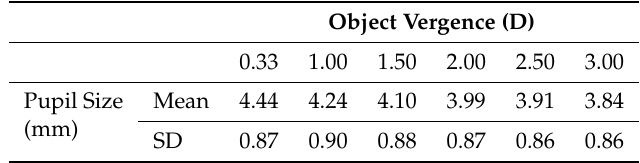
Table 2. Pupil diameter as a function of object vergence (mean ±